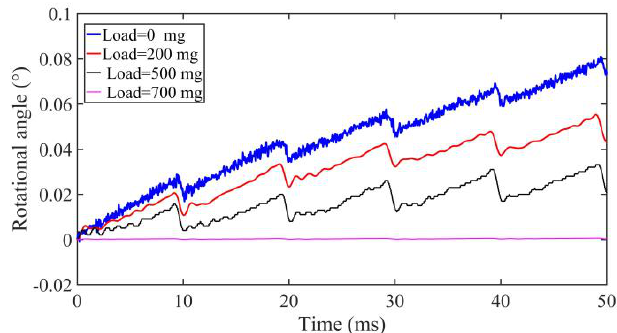
Figure 14. Rotational angle under different external loads at 100 Hz.